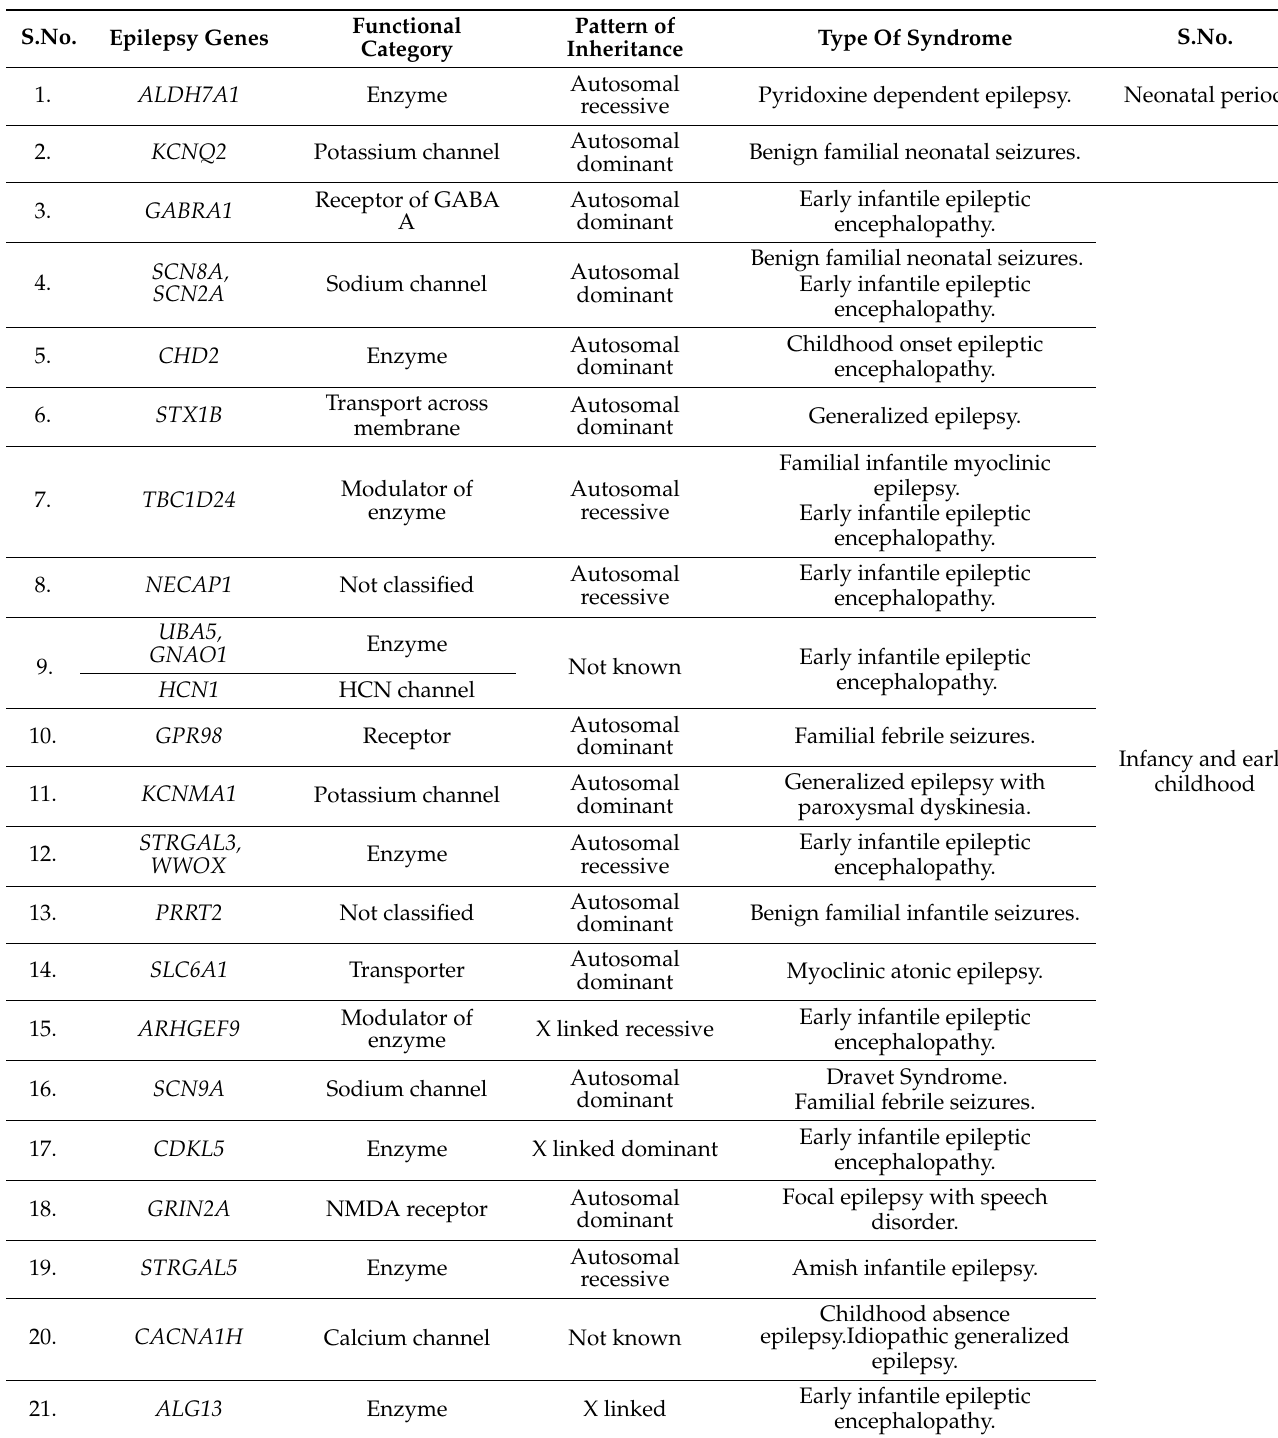
Table 1. List of genes associated with the pathophysiology of epilepsy. The pattern of inheritance, age of onset, and functional categories has been given in concurrence with the associated genes.